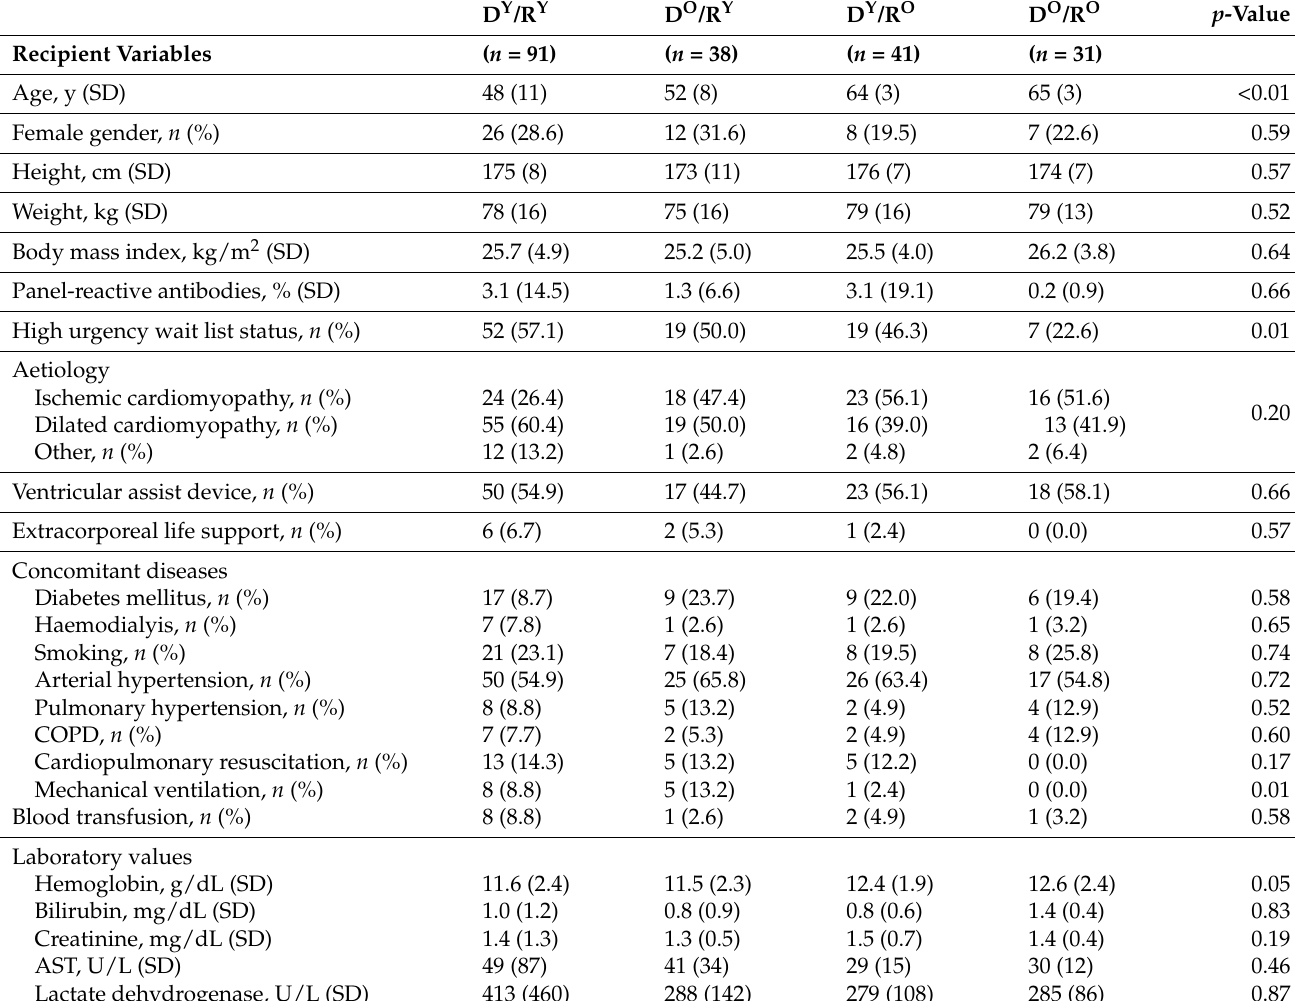
Table 1. Preoperative recipient